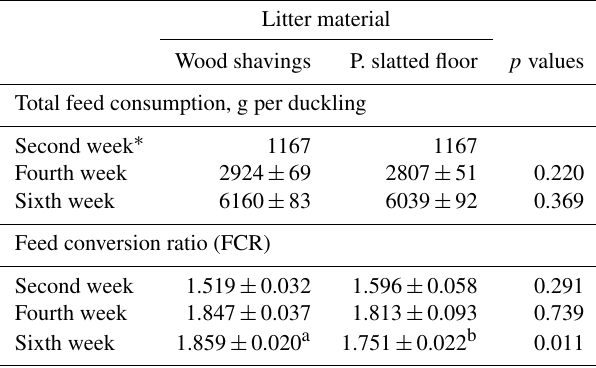
Table 3. The effects of PSF and WSs on feed consumption and FCR of Pekin ducks (mean ± SEM).